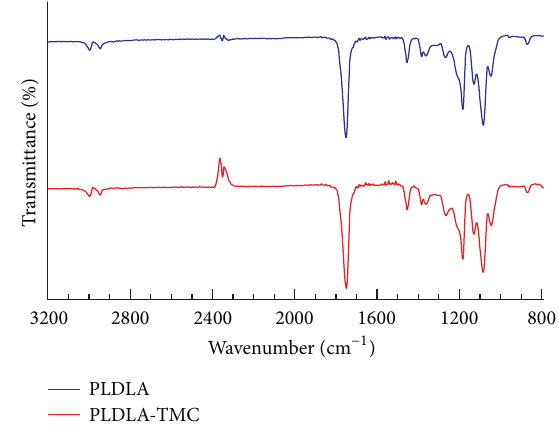
Figure 3: FT-IR spectra of PLDLA and